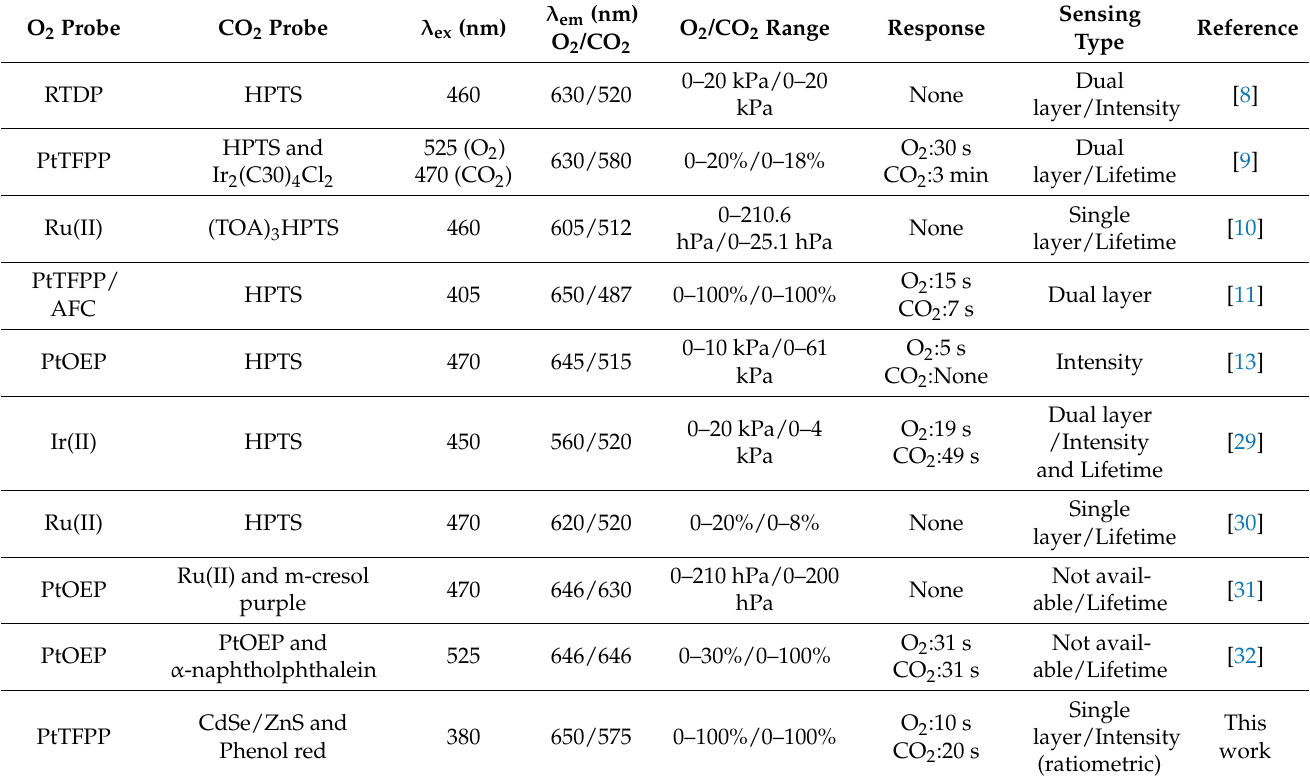
Table 1. Properties of typical optical O 2 and CO 2 dual